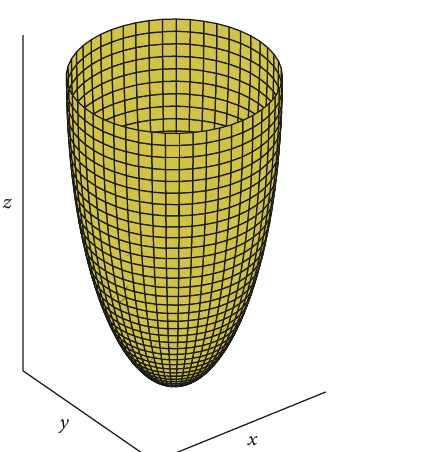
Figure 2: TPS generated by the rotation if the curve is defined by